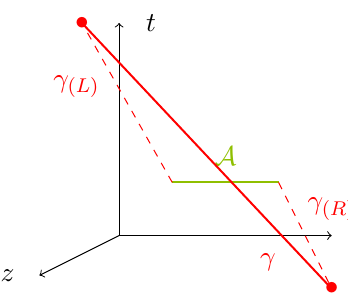
Figure 2 . A simplified sketch depicting a swing surface for a boundary interval A in a bulk space with time coordinate t and radial coordinate z . The dashed lines γ while the solid line γ is the (spacelike)